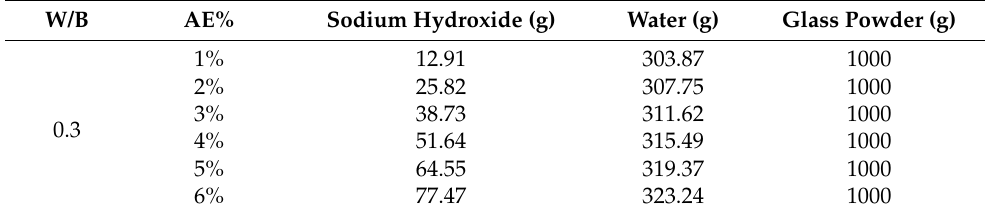
Figure 1. X-ray diffraction patterns of the glass